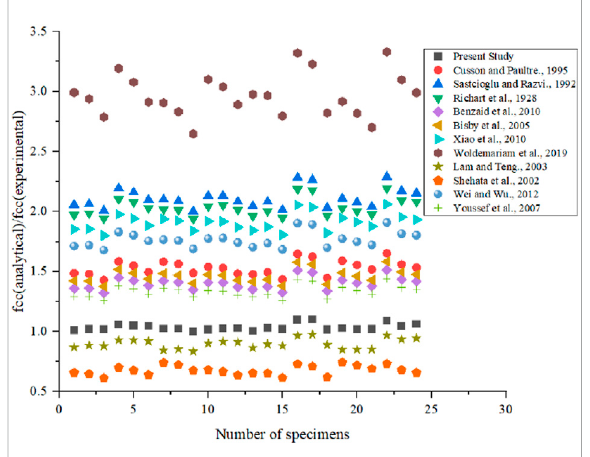
FIGURE 16 Predicted models for peak stress estimation with the longitudinal